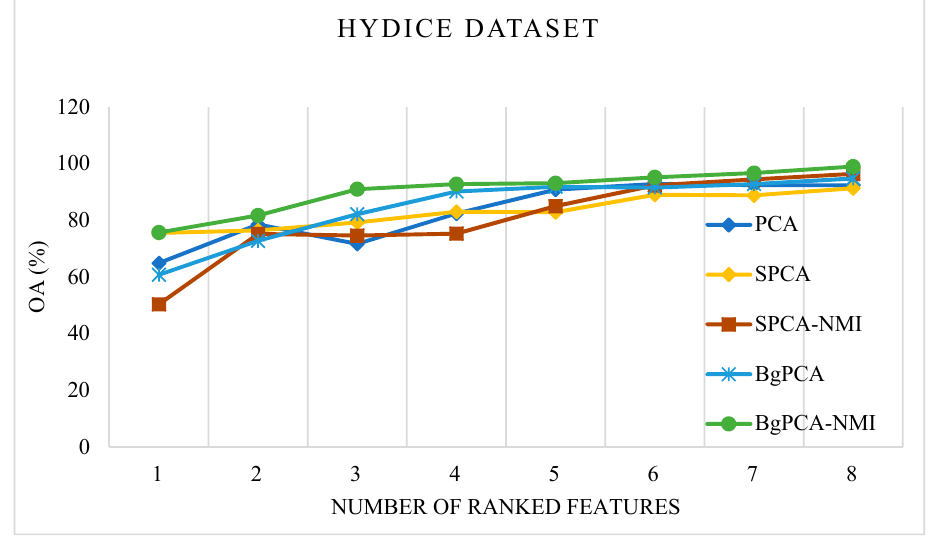
Table 6. Detailed classification outcomes for the Washington DC Mall